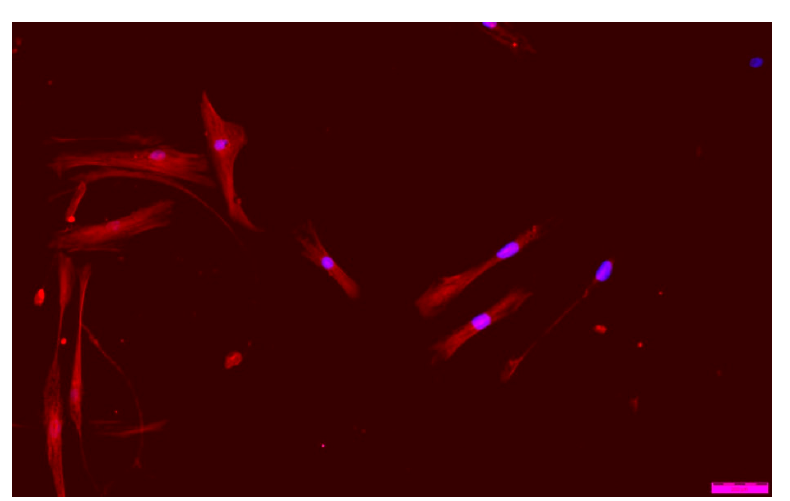
Figure 11. EDX spectrum of the sample (ALG-PFC) net .